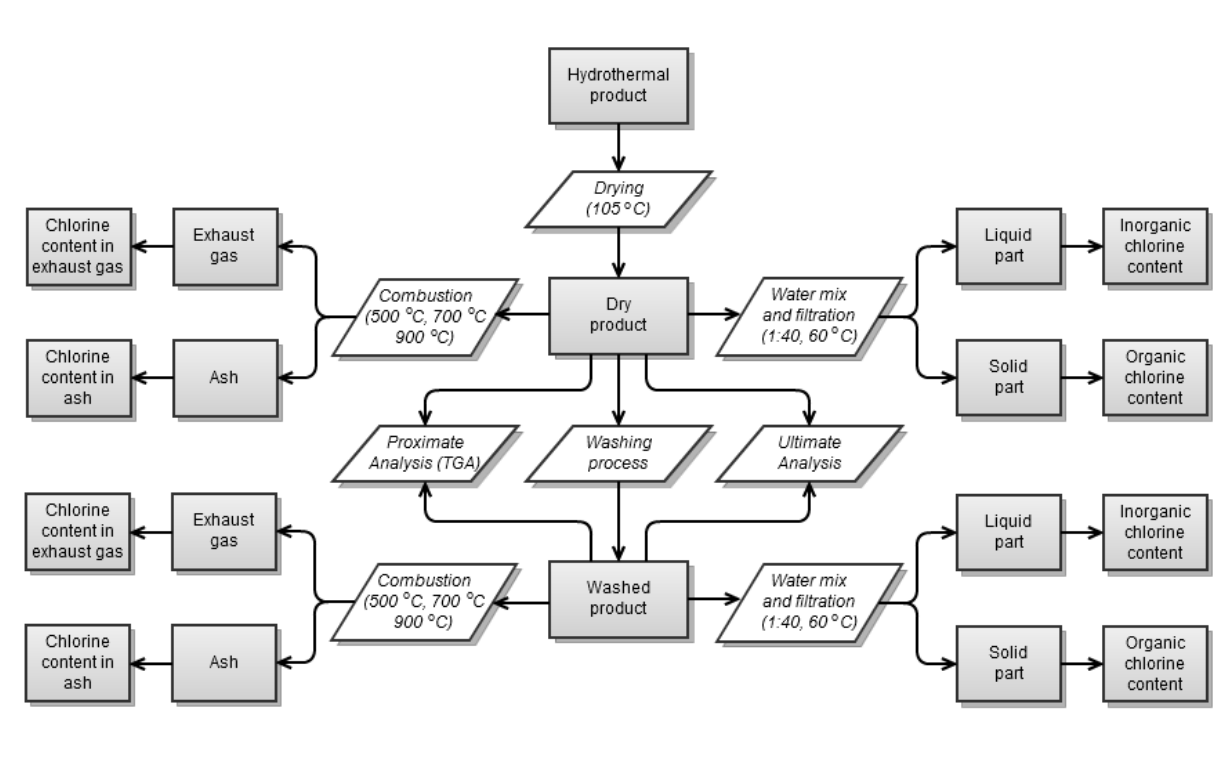
Figure 3. Material analysis